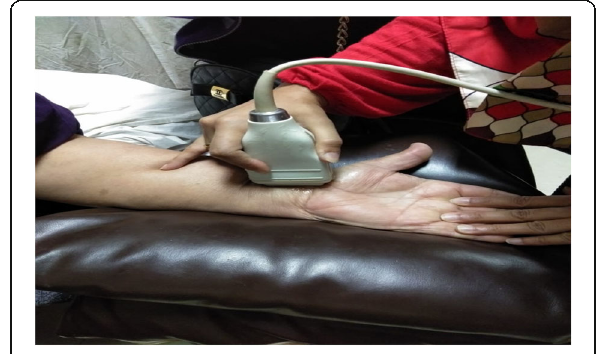
Fig. 4 Ultrasound image shows basiform bone and scaphoid bone, and the arrow shows the median